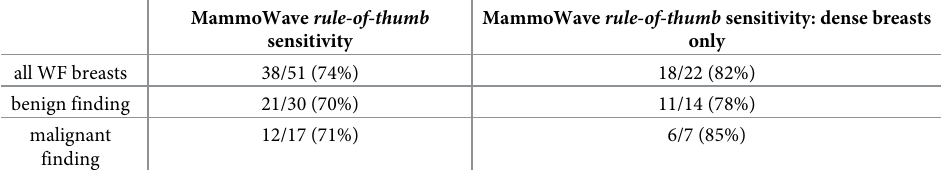
Table 5. MammoWave rule-of-thumb sensitivity is summarized (second row) for the WF breasts (both full set and dense breasts only): Sensitivity is expressed as numerator/denominator (where the numerator represents the num- ber of rule-of-thumb positive identification and the denominator represents the total number of WF breasts) and in percentages (given in brackets and rounded to nearest whole number). MammoWave rule-of-thumb MammoWave rule-of-thumb sensitivity: dense breasts sensitivity only all WF breasts 38/51 (74%) 18/22 (82%) benign finding 21/30 (70%) 11/14 (78%) malignant 12/17 (71%) 6/7 (85%) finding